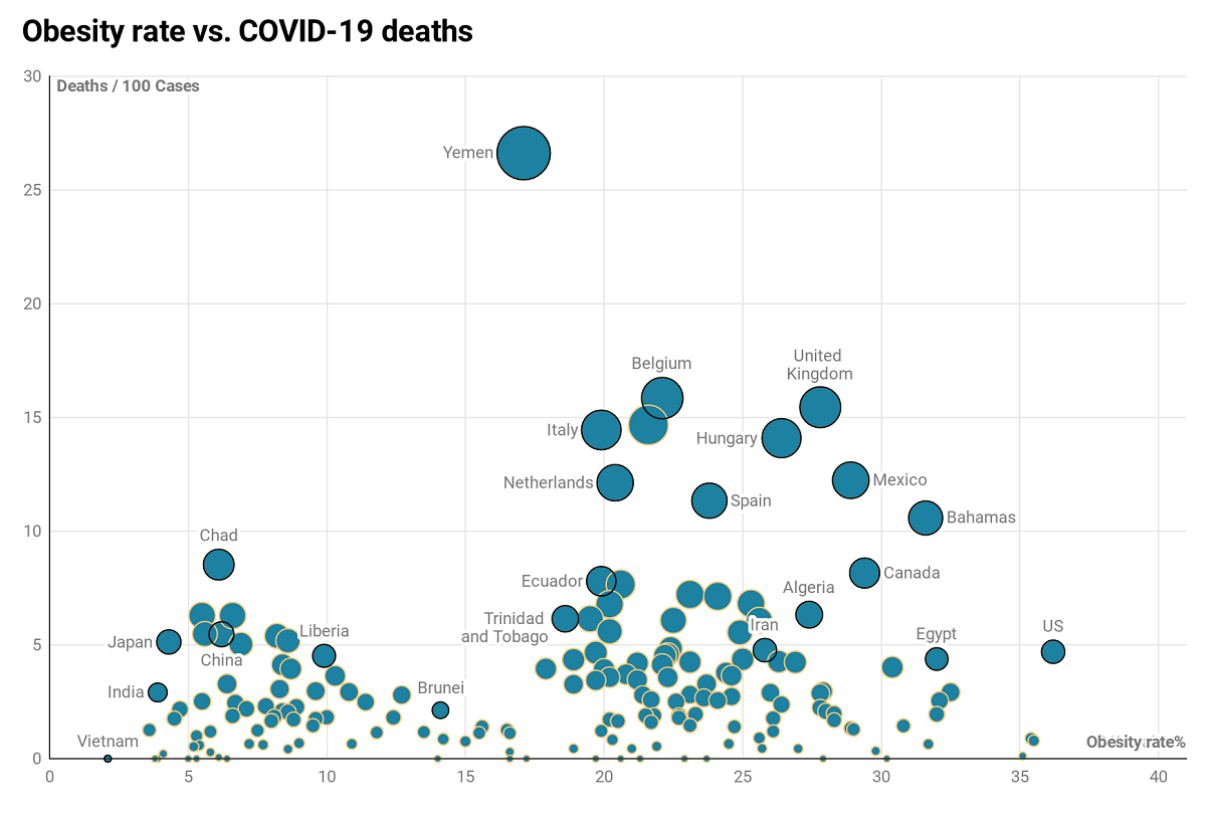
Figure 4. Scatterplot of obesity rate versus deaths per 100 cases of COVID-19 by country. The circle’s size is related to the number of deaths per 100